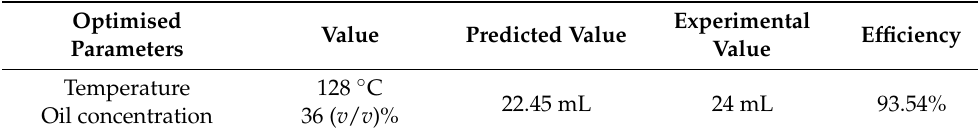
Table 7. Model validation of predicted optima values.